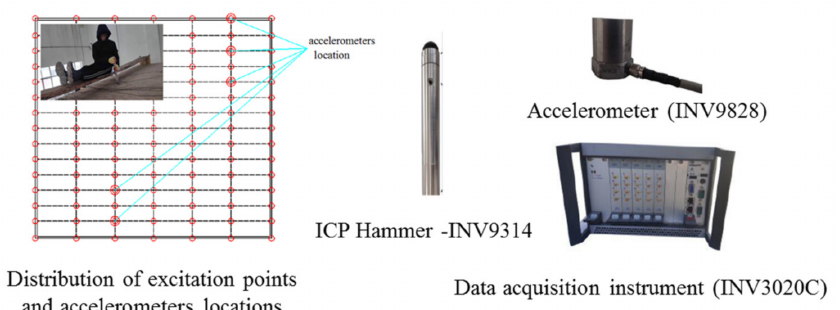
Figure 4. Vibration mode and frequency tests.